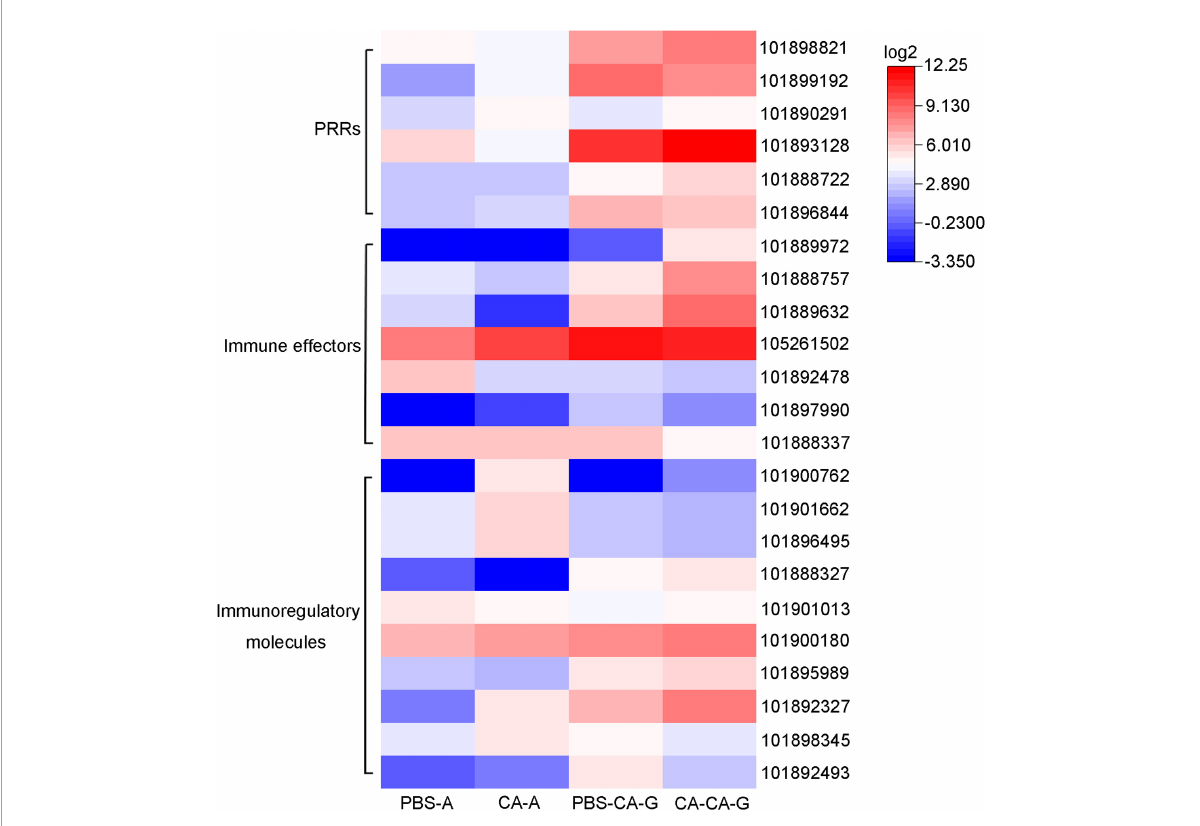
FIGURE9 Expression of differentially expressed immune genes. Heat map shows the expression of differentially expressed immune genes, including 6 PRRs, 7 immune effectors, and 10 immunoregulatory molecules. The color scale indicates the expression level of the